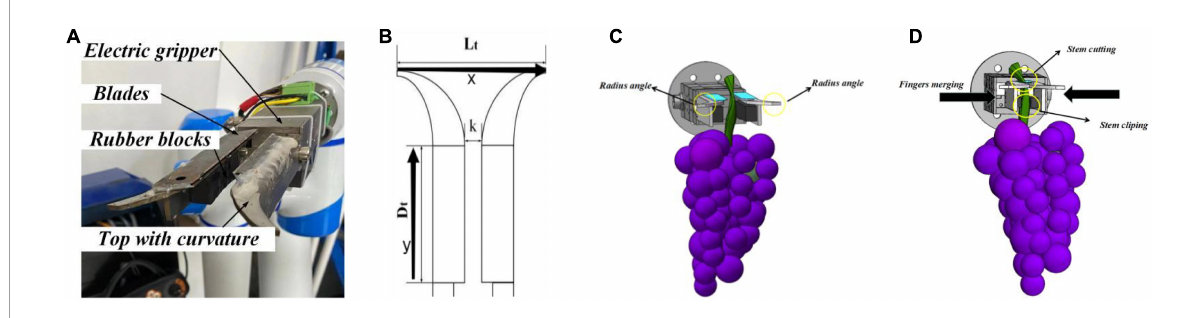
FIGURE10 (A) Construction of the end effector; (B) error tolerance in the end effector; (C) end effector opening; and (D) end effector